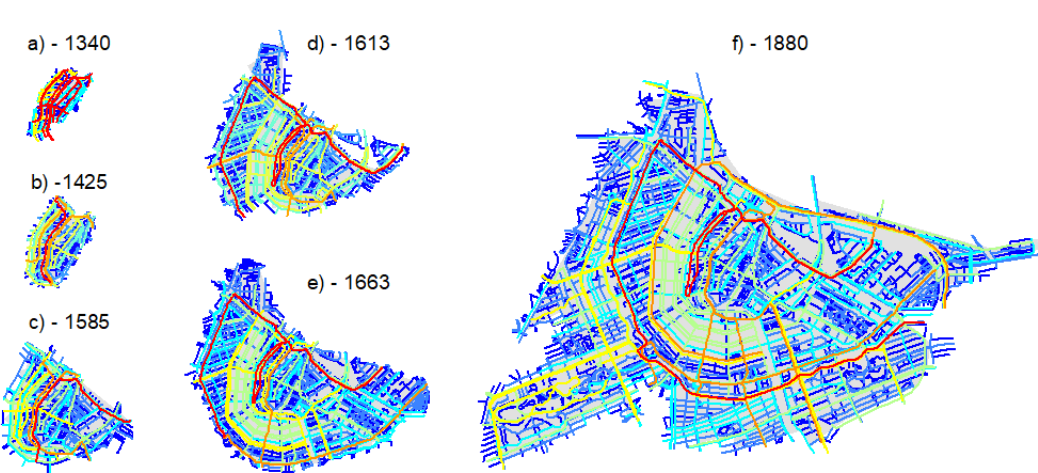
Figure 8. Historical development of Amsterdam. Well-connected streets are denoted by warmer colors (red), and the least connected streets are denoted by colder colors (blue). This shows that slow historical expansions leave living structure intact, as seen by the most well-connected street (in red) expanding and being located centrally.